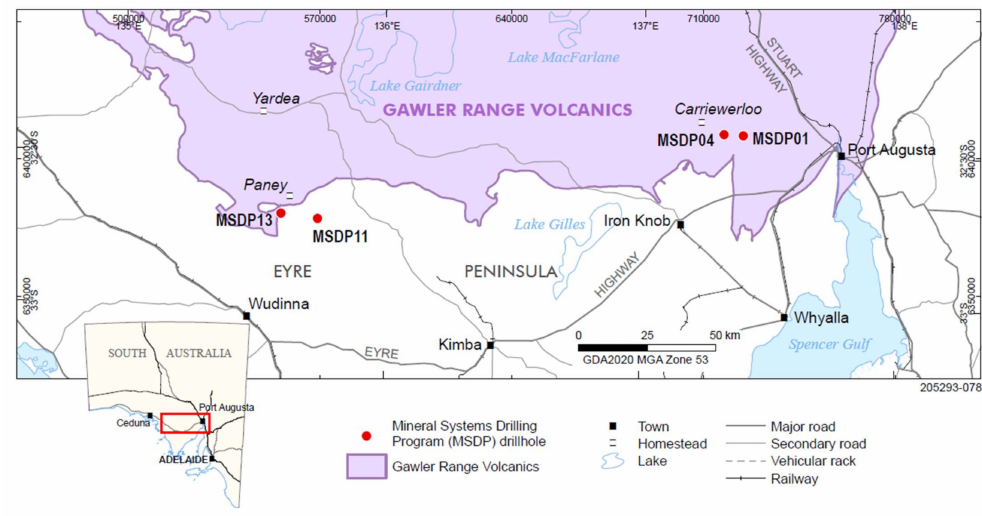
Figure 3. Location of drill holes MSDP01, 04, 11 and 13 for the Mineral Systems Drilling Program, southern Gawler Ranges, South Australia. Coordinate system is Geocentric Datum of Australia (GDA) 2020, Map Grid Australia (MGA) Zone 53.